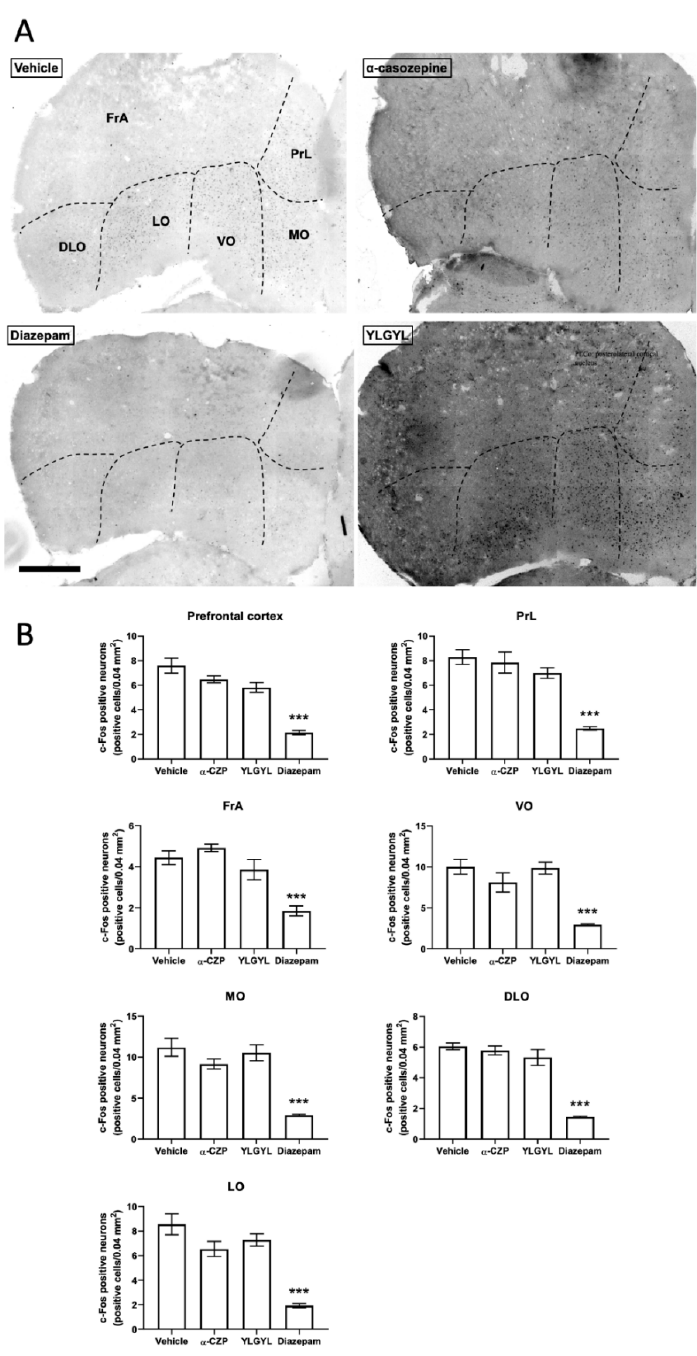
Figure 4. The e ff ects of α -casozepine ( α -CZP, 1 mg / kg, IP), YLGYL (0.5 mg / kg, IP), or diazepam (1 mg / kg, IP) on anxiety-induced c-Fos immunoreactivity in the prefrontal cortex. ( A ) Photomicrographs displaying the e ff ects of the vehicle, α -CZP, YLGYL, or diazepam on anxiety-induced c-Fos immunoreactivity in the prefrontal cortex (coronal sections, bregma 2.68 mm). The green channel was extracted, and the colours were inversed while the contrast was increased to 40% for better visualisation. Scale bar: 500 µ m. ( B ) Corresponding densities of c-Fos immunopositive cells (displayed as number of positive cells / 0.04 mm 2 ). Data are mean ± SEM ( n = 4 / group). Results were analysed using a one-way ANOVA followed by a Bonferroni post hoc test to compare the e ff ect of α -CZP, YLGYL, and diazepam to the vehicle (*** p < 0.001). FrA: frontal association cortex; PrL: prelimbic cortex; DLO: dorsolateral orbital cortex; LO: lateral orbital cortex; VO: ventral orbital cortex; MO: medial orbital